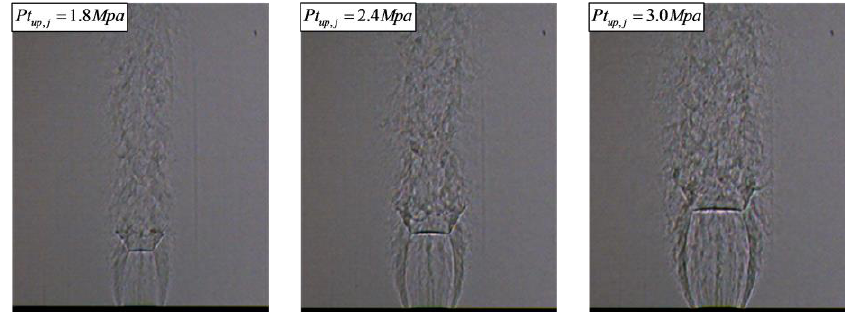
Figure 4. Shadow diagram of the free expanding jet for three different jet upstream pressures; see the legends of each image. Table 2. Resulting jet exit flow properties at the sonic orifice.